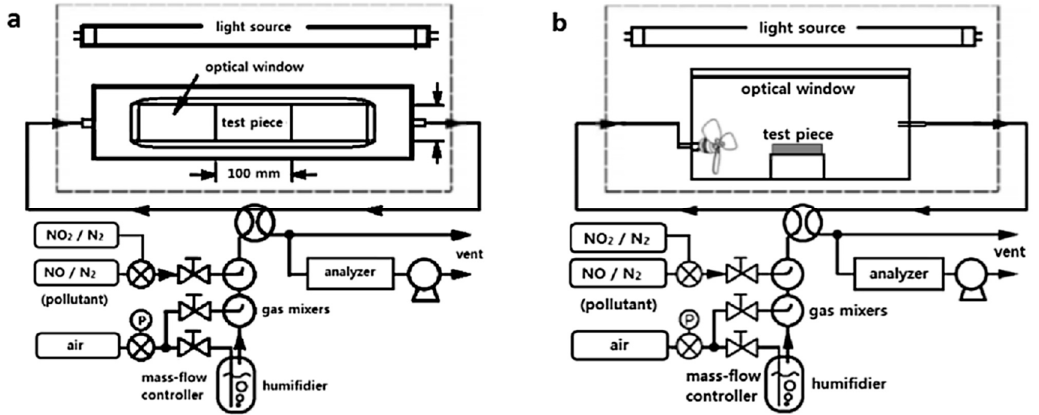
Figure 37. Experimental laminar flow ( a ); and ideally-mixed flow ( b ) reactors used to examine the photocatalytic oxidation of low concentrations of gas NO x streams at some specified humidity.